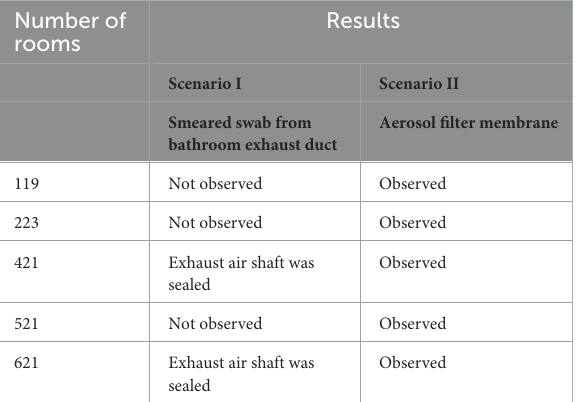
TABLE 1 The results of on-site simulation experiments in building